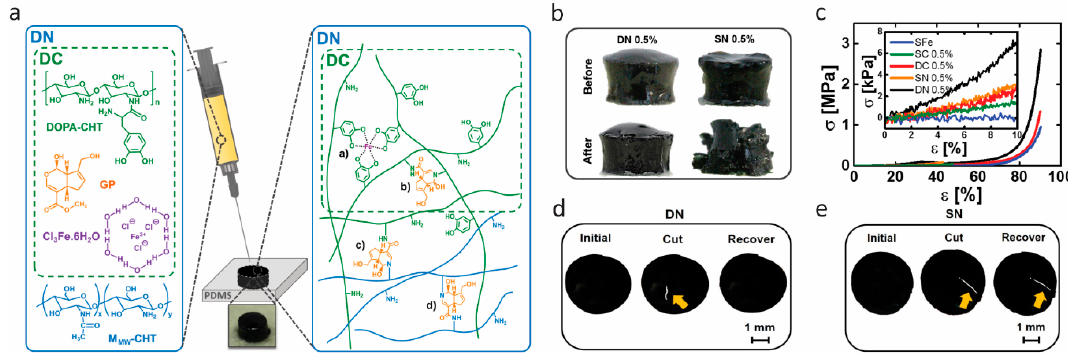
Figure 4. Double cross-link/double network hydrogels with high toughness based on catechol coordination and genipin-mediated covalent cross-links of chitosan. ( a ) Illustration of the concept leading to double cross-link (DC) and double network (DN) hydrogels. ( b , c ) Robustness of hydrogels: ( b ) Images of two different hydrogels cross-linked with 0.5% (w/v) genipin:DN (double network of genipin and coordination bonds as displayed in ( a )) and 0.5% (w/v) genipin:SN (single network of genipin cross-linked chitosan) before and after compression at 50% strain. ( c ) Typical compressive stress–strain curves of different hydrogels with 0.5% (w/v) genipin. ( d , e ) Self-healing test of hydrogels: ( d ) Images of DN and ( e ) SN hydrogels before being cut with a blade (initial) , cut (yellow arrow), and after resting for 5 min (recover). Reprinted from [51] by permission of John Wiley & Sons, Inc.